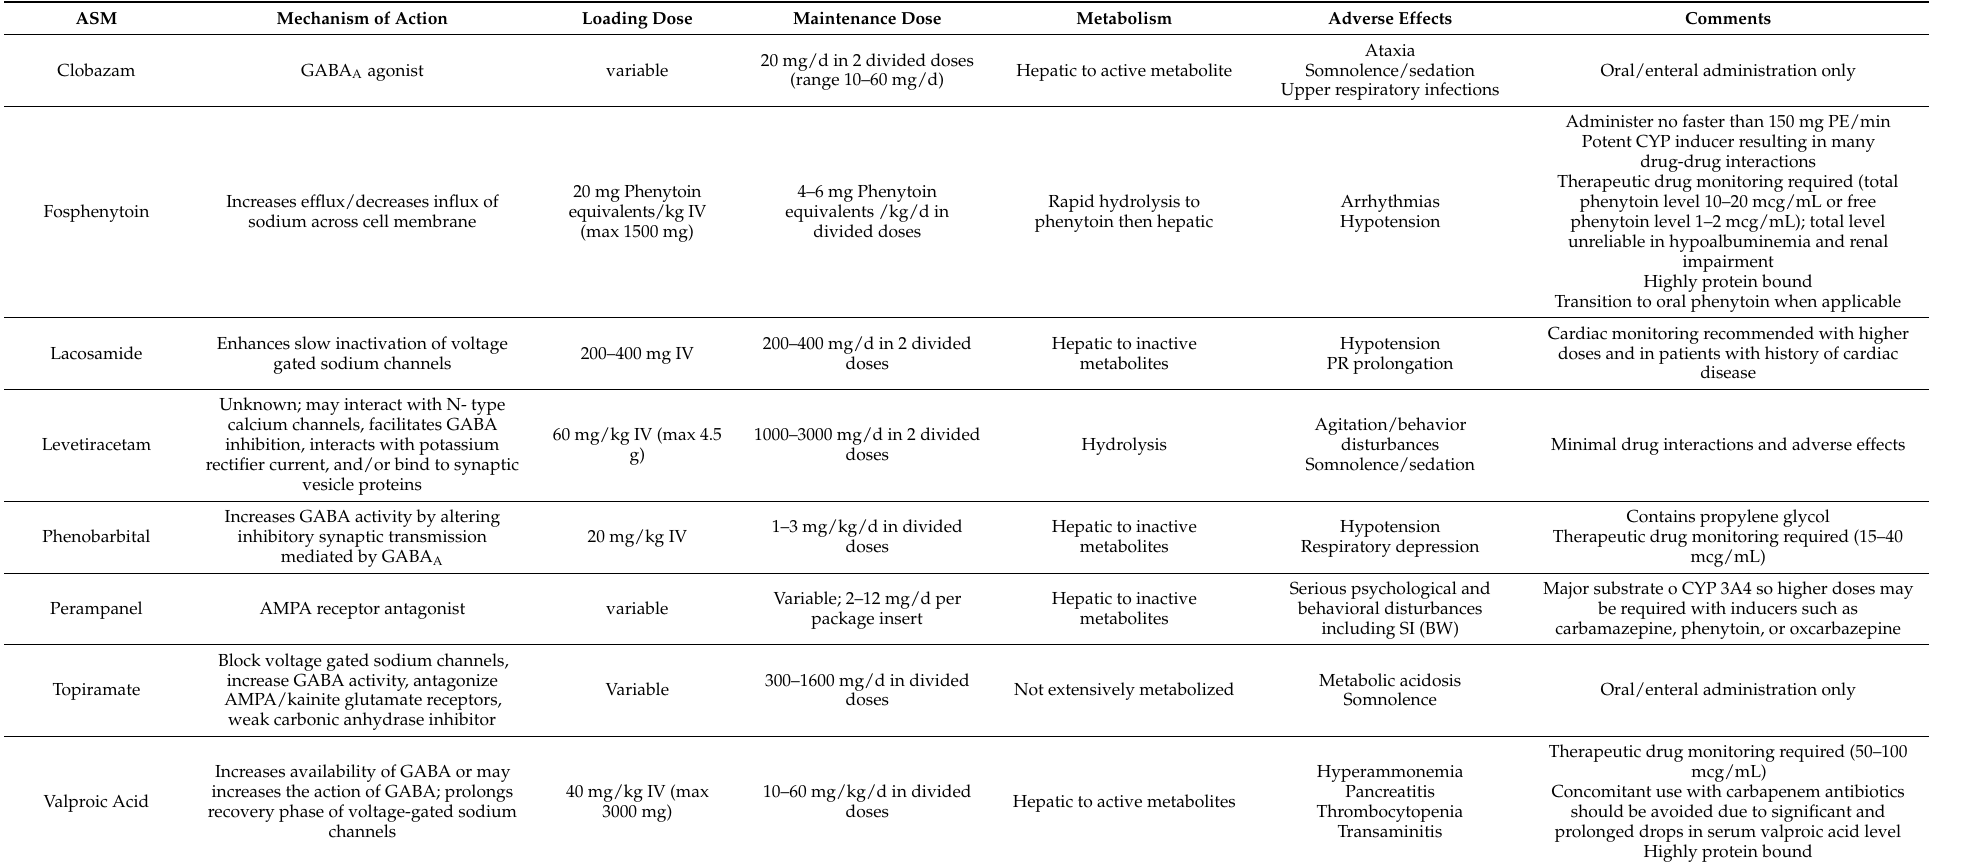
Table 1. Commonly used ASMs for the treatment of refractory and super-refractory status epilepticus (RSE and